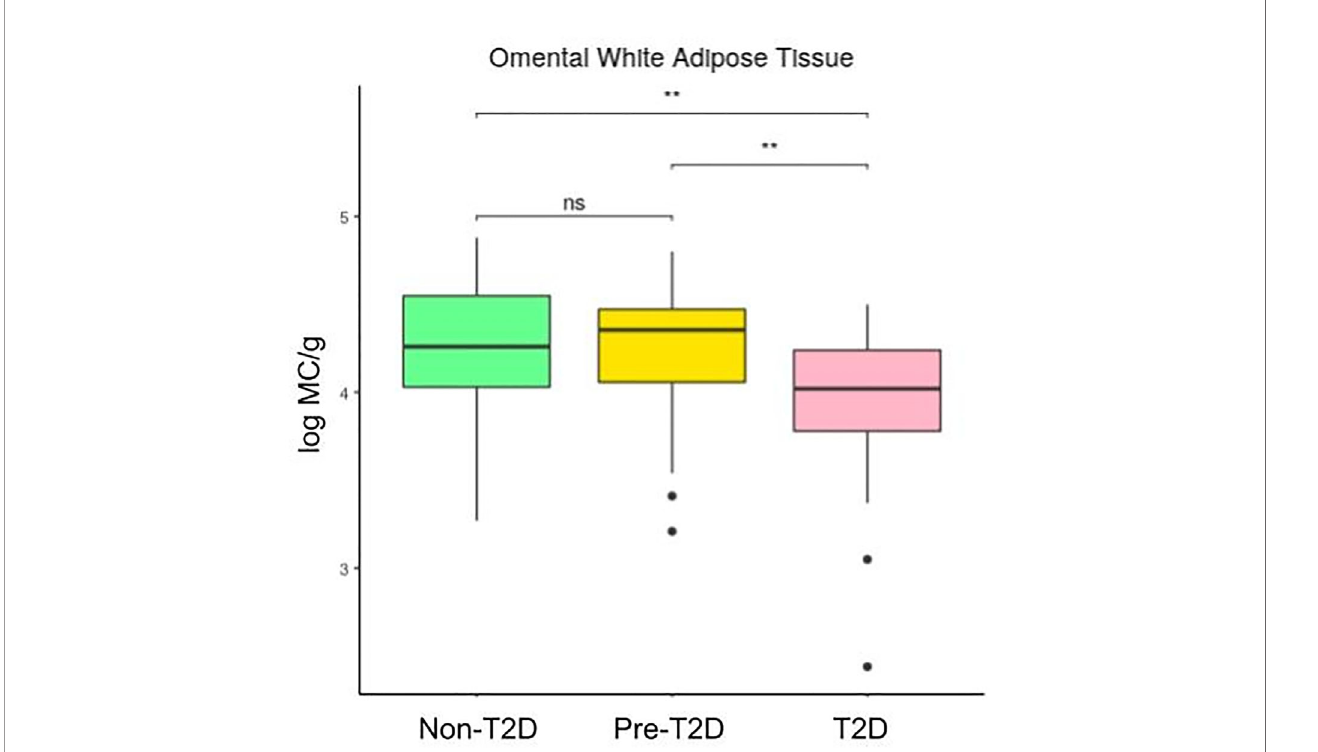
FIGURE 2 | Differences in mast cells per gram of tissue in omental white adipose tissue depending on the type 2 diabetes status. The data comes from the big cohort (n = 100). MC (mast cells), T2D (type 2 diabetes), “ ns ” (p-value > 0.05), “ ** ” (0,01 > p-value).